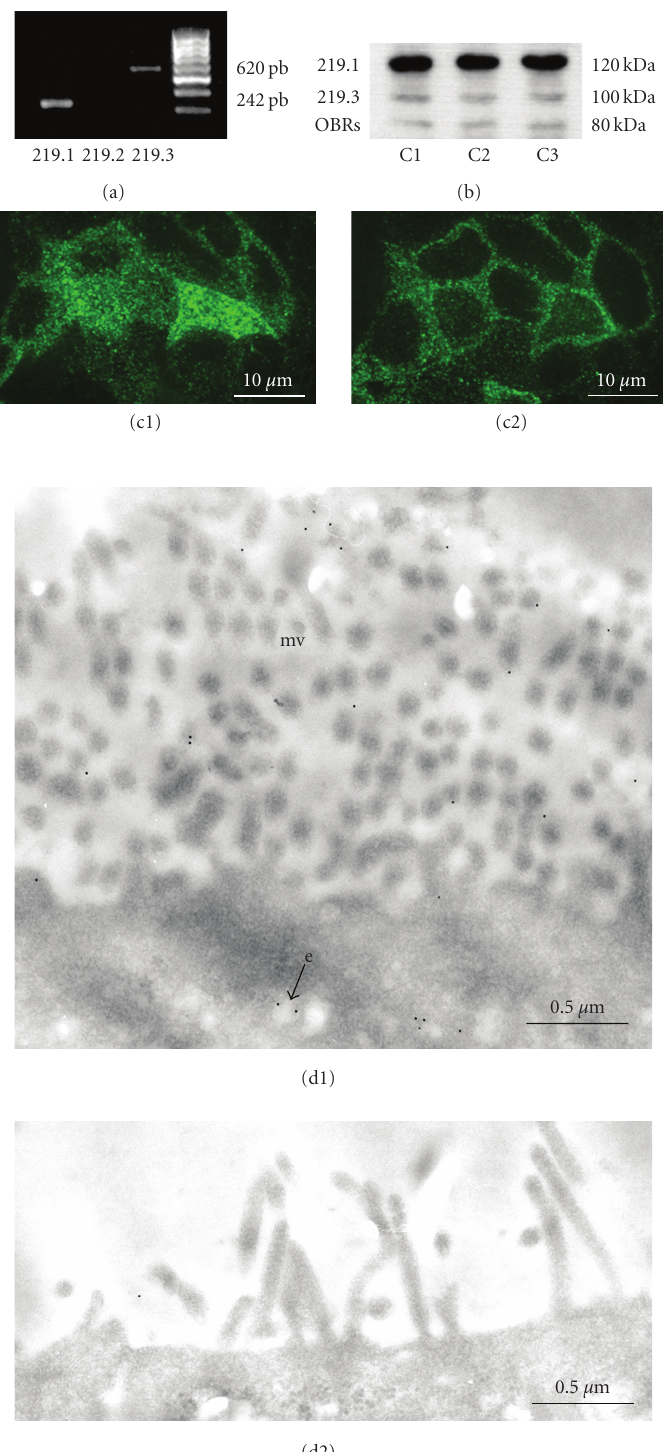
Figure 3: Presence of leptin receptors in Caco-2/15 cells . (a) Leptin receptor long (219.1) and short (219.3) isoform mRNAs are present in Caco-2/15 cells as revealed by RT-PCR analysis. (b) In three di ff erent experiments (C1, C2, C3), Western blots demonstrate the presence of the long (219.1) (120kDa) and short (219.3) (100kDa) isoforms of the leptin receptor, as well as that of the soluble receptor (OBRs) (80kDa). The isoform 219.2 was not found. Confocal microscopy carried out on cell monolayer displays intense green staining for the leptin receptor on the apical pole of the cells (c1) and a more granulated and dispersed staining on more central regions of the same cells (c2). (d1) Immunogold electron microscopy confirms the presence of the leptin receptor on the apical plasma membrane particularly at the level of the microvilli (mv) and on the limiting membrane of endocytotic vesicles where gold particles are easily detected (e). (d2) Control of specificity: cell monolayers were incubated without the primary antibody showing absence of labelling by gold